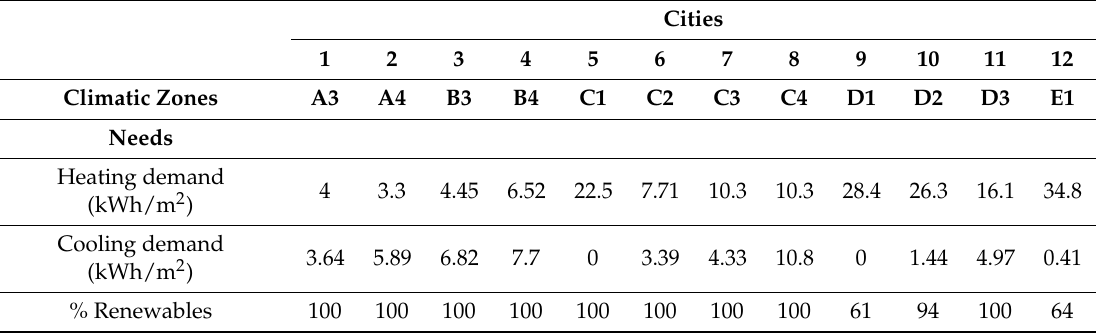
Table 6. Building envelope and active element with